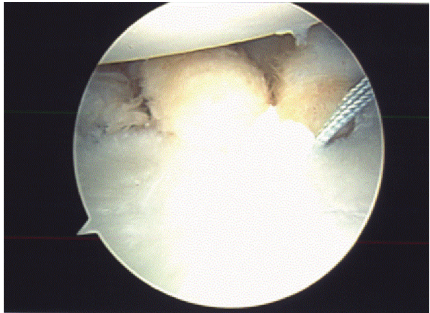
Figure 6: Arthroscopic image of a posteroinferior labral repair through a 7 o’clock portal as an adjunct to anterior stabilization in a patient with recurrent shoulder